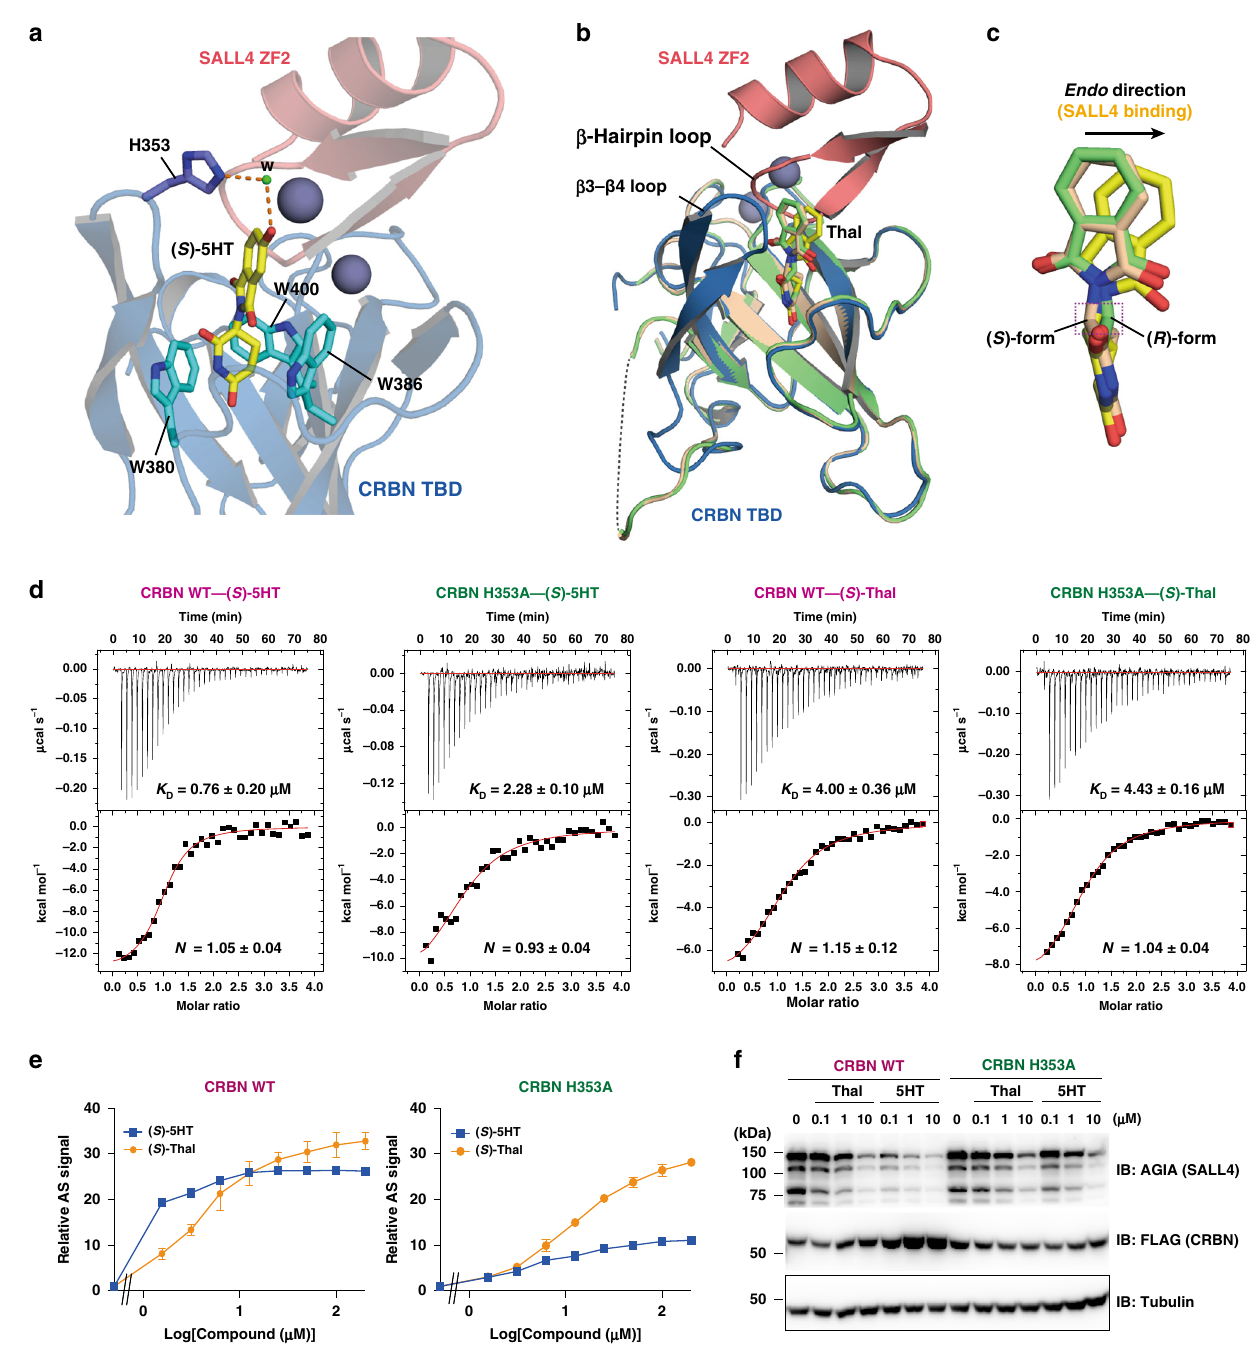
Fig. 3 Structural bases for the effective ( S )-5HT mediation of the CRBN ‒ SALL4 interaction. a The binding mode of ( S )-5HT on the interface between the CRBN TBD and SALL4 ZF2. The H353 residue forms hydrogen bonds (dashed lines) with the 5-hydroxy group of ( S )-5HT through a water molecule (dot labeled w). Gray spheres are zinc ions bound to the CRBN TBD and SALL4 ZF2. b Superimposed structures of the CRBN TBD in complex with SALL4 and ( S )-thalidomide (Thal, blue), neosubstrate-free state binding of ( S )-Thal (wheat) and ( R )-Thal (lime). ( S )-Thal in the SALL4 – CRBN complex is represented by yellow sticks, and the stick models of ( S )- and ( R )-Thal are colored the same as the coordinates in CRBN in the neosubstrate-free state. Zinc ions are shown as gray spheres. The black dashed line connects the missing chain of the neosubstrate-free CRBN TBD, which corresponds to a part of two β - strands, β 3 and β 4, observed in the SALL4 – CRBN complex. The structures of the neosubstrate-free CRBN with ( S )- and ( R )-Thal were generated from the coordinates deposited in the PDB under accession numbers 5YJ0 and 5YJ1 37 . c Enlarged views of the stick models of Thal in b . d ITC thermograms of the wild-type (WT) and H353A mutant of the CRBN TBD titrated with ( S )-5HT and ( S )-Thal. The values of the dissociation constant ( K D ) and molar binding ratio ( N ) were calculated with mean values± SD ( n = 3 independent experiments). e Effect of the H353A mutation in CRBN on the SALL4 interactions induced by ( S )-5HT or ( S )-Thal. AS signals are expressed as the relative luminescence signal relative to the luminescence signal of DMSO, which is considered equal to one. Data are presented as mean values ± SD ( n = 3 independent experiments). f Effect of the H353A mutation in CRBN on the (S)- 5HT- or (S)-Thal-mediated proteasomal degradation of SALL4. The experiment was repeated three times independently with similar